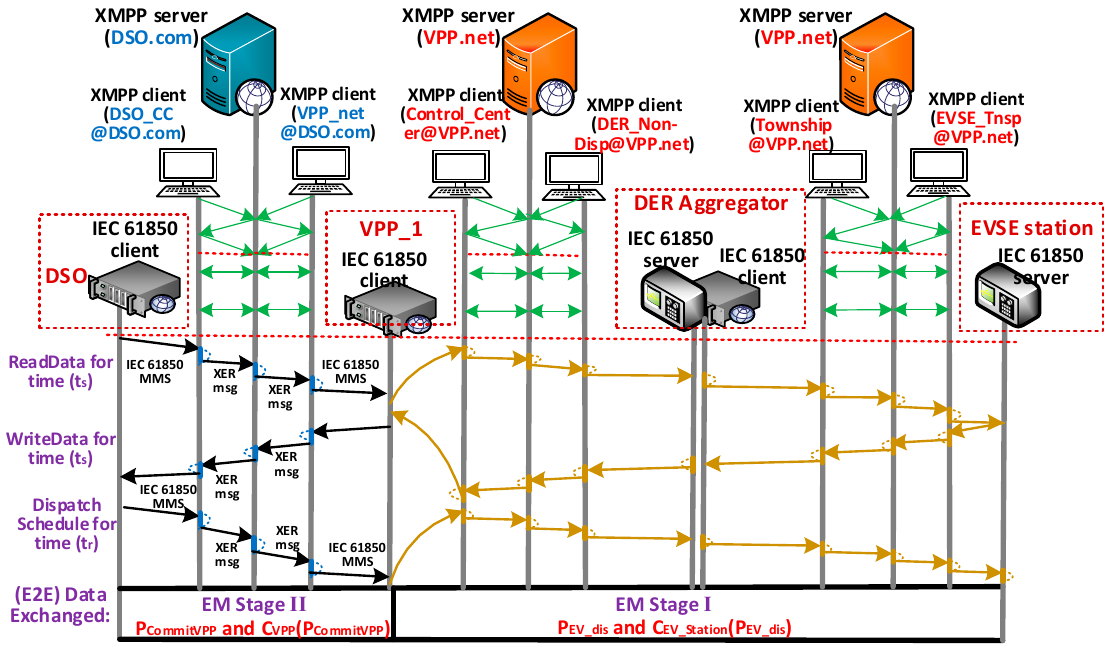
Figure 6. Message flow between DSO and EVSE charging station for EM in multiple